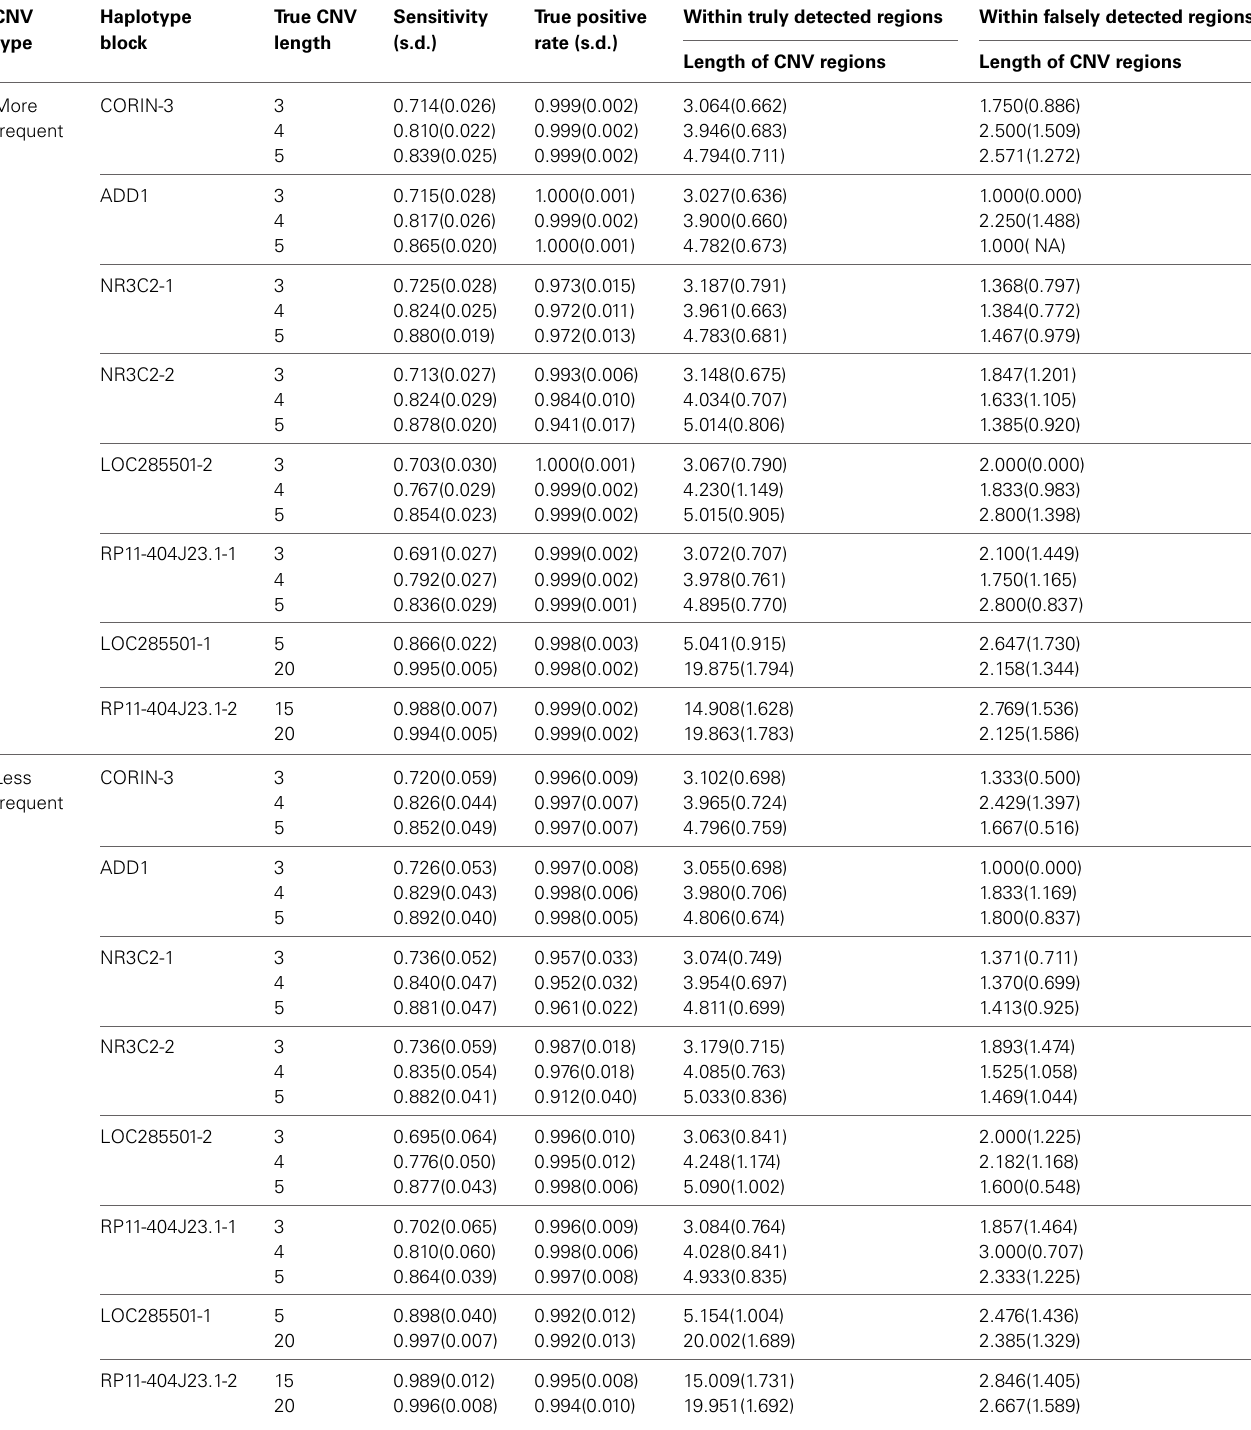
Table 2 | Summary of CNP regions and genotypes called from